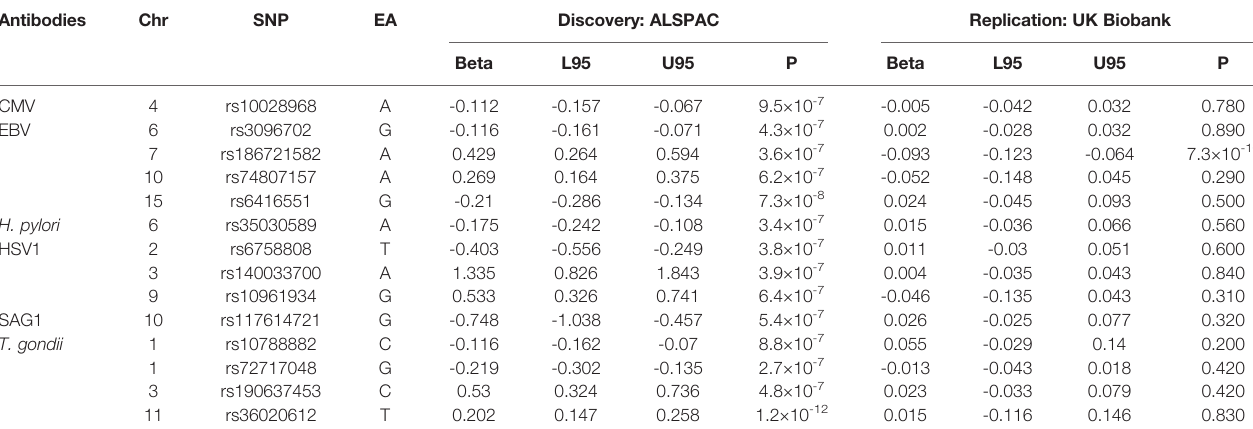
TABLE 6 | Replication of associations observed in the ALSPAC seven-year clinic GWAS in UK Biobank ( P < 5.9×10 -4 ). Antibodies Chr SNP EA Discovery: ALSPAC Replication: UK